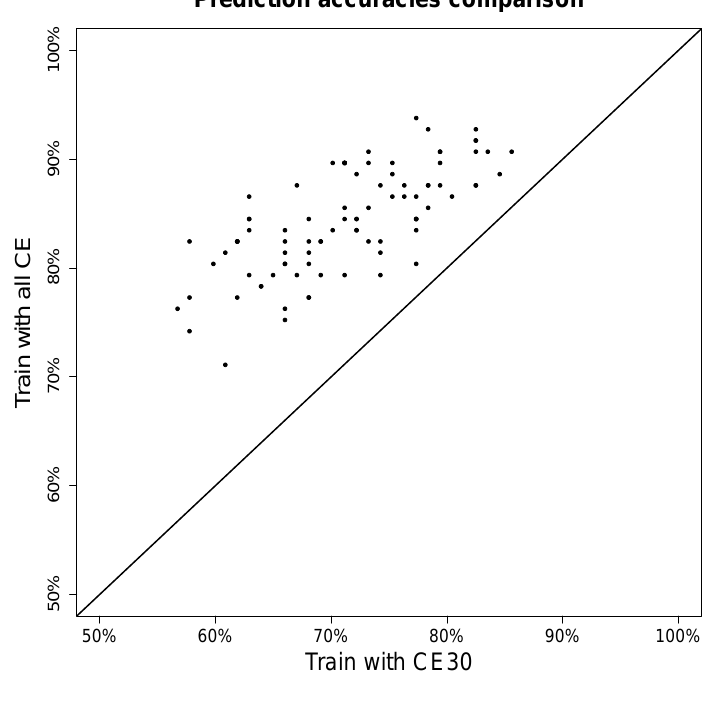
, which is the number of molecules having the N dp